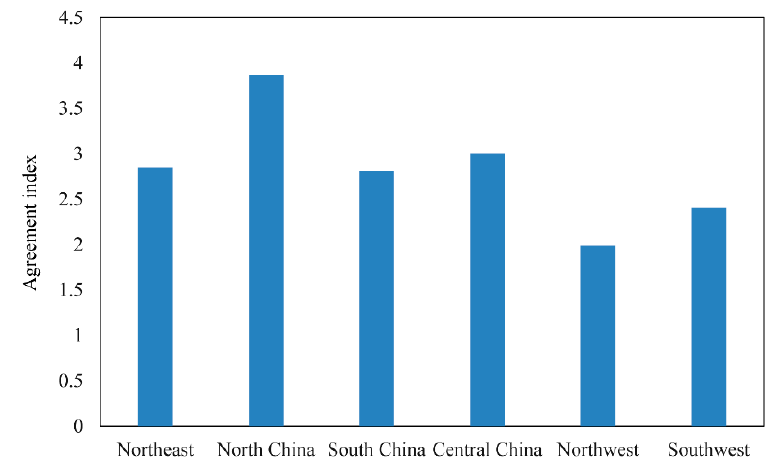
Figure 4. Value of the agreement index in each of the six regions.